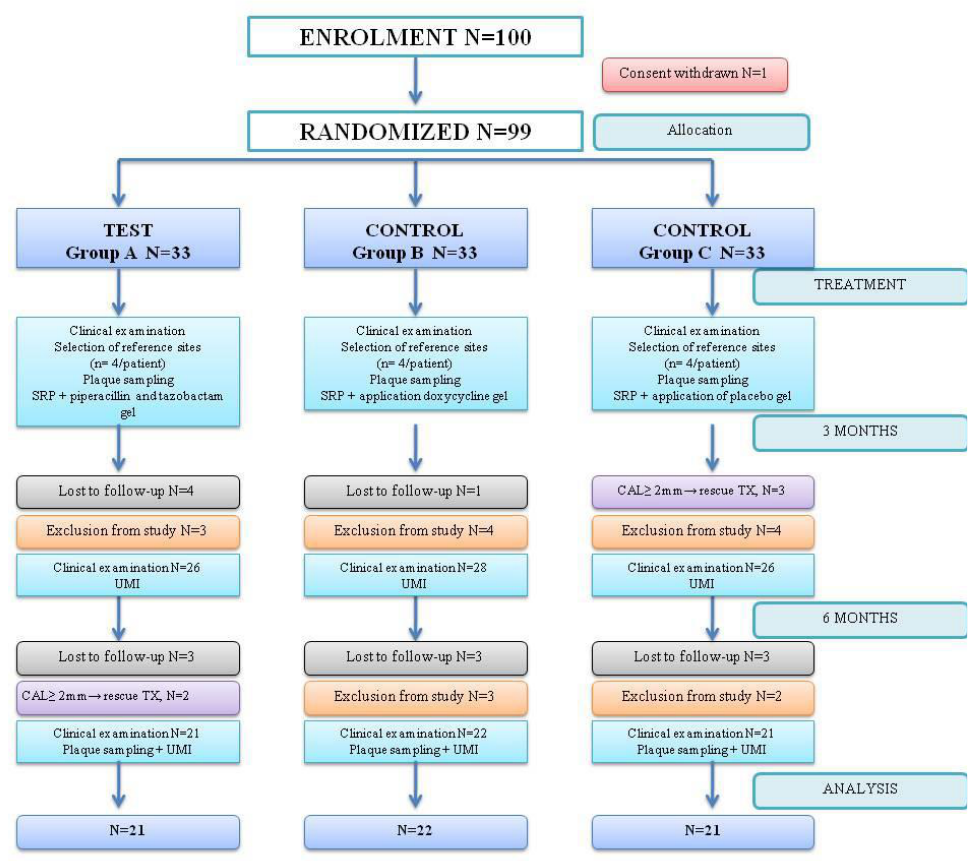
Figure 2. CONSORT Diagram and patient allocation.